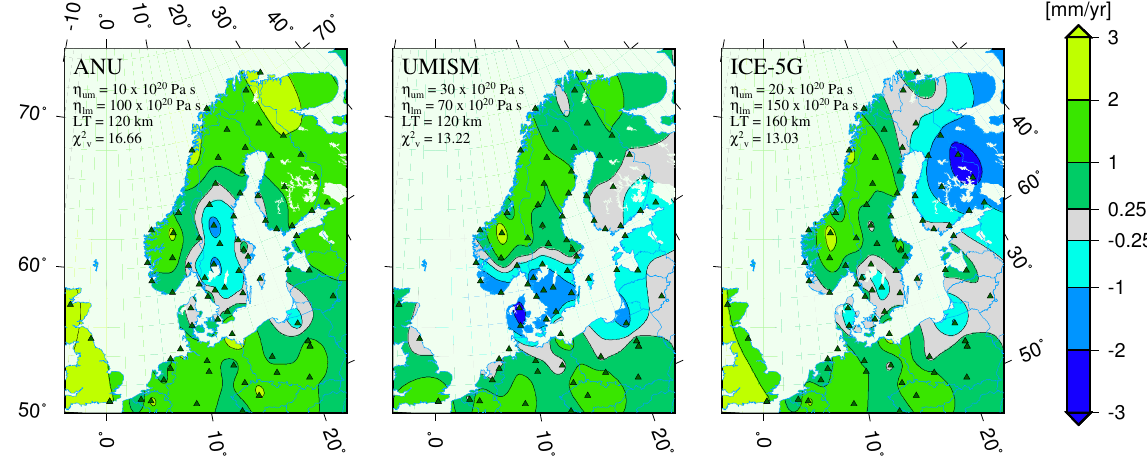
Figure 8. Residual vertical Bifrost velocities after subtraction of the best-fit earth models of ANU (left), UMISM (middle) and ICE-5G (right). Positive residuals (green colours) show where the reconstructions under-predicts the present-day uplift, whereas negative residuals (blue colours) show regions of over-predictions. Red triangles indicate the location of the stations in the Bifrost network.